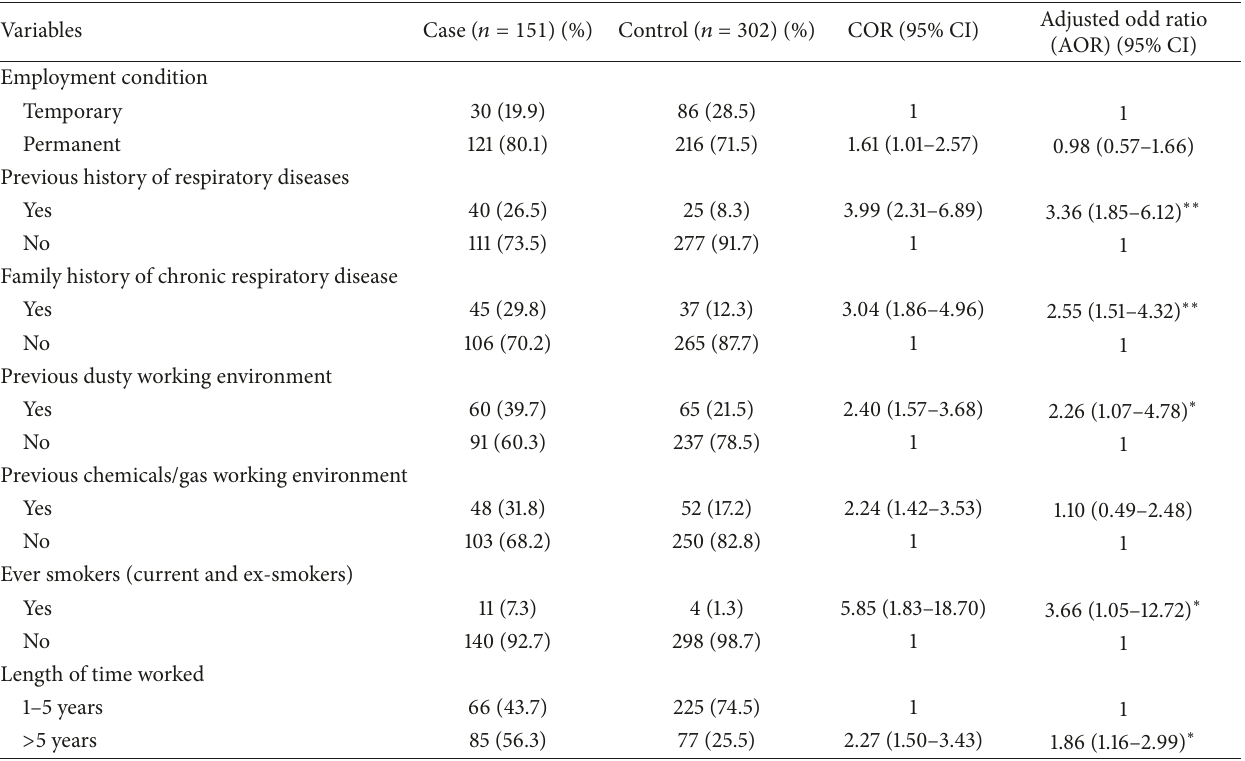
Table 6: Multiple logistic regression model of associated factors and chronic respiratory symptoms among pharmaceutical factory workers in Addis Ababa, Ethiopia, May